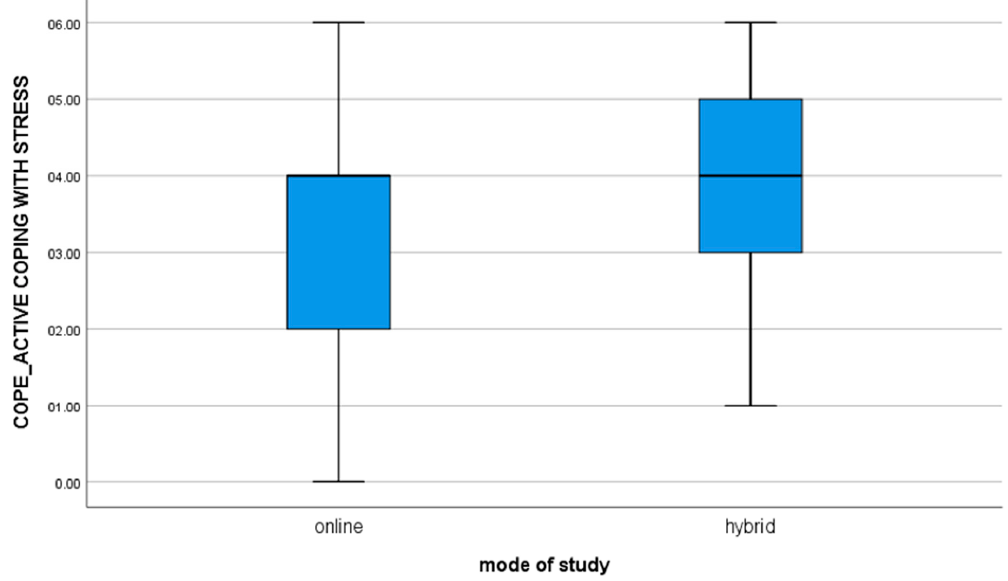
Figure 1. For the variable COPE_ACTIVE COPING WITH STRESS.